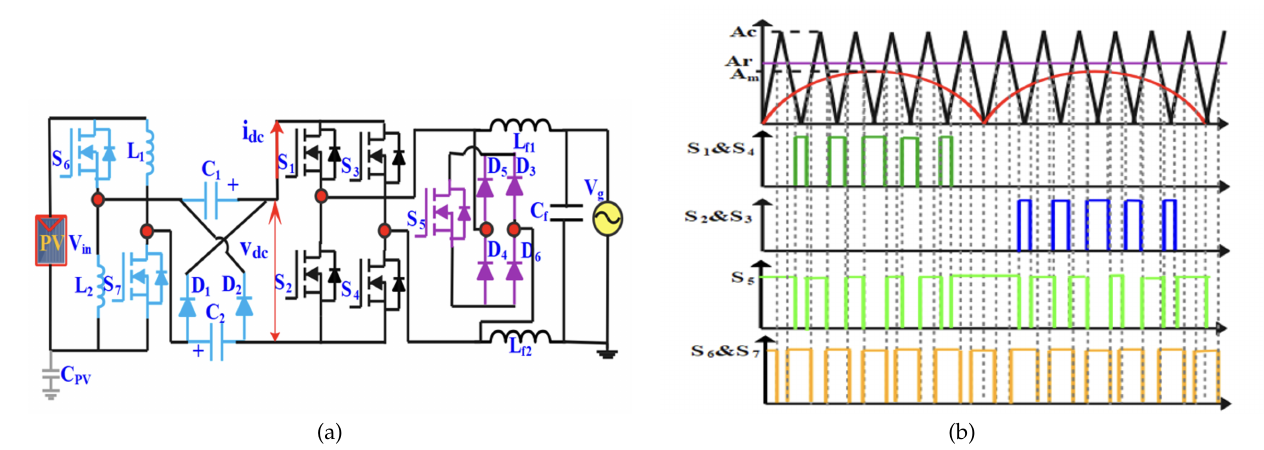
Fig. 2. (a) Structure of proposed topology (b) Switching pulses